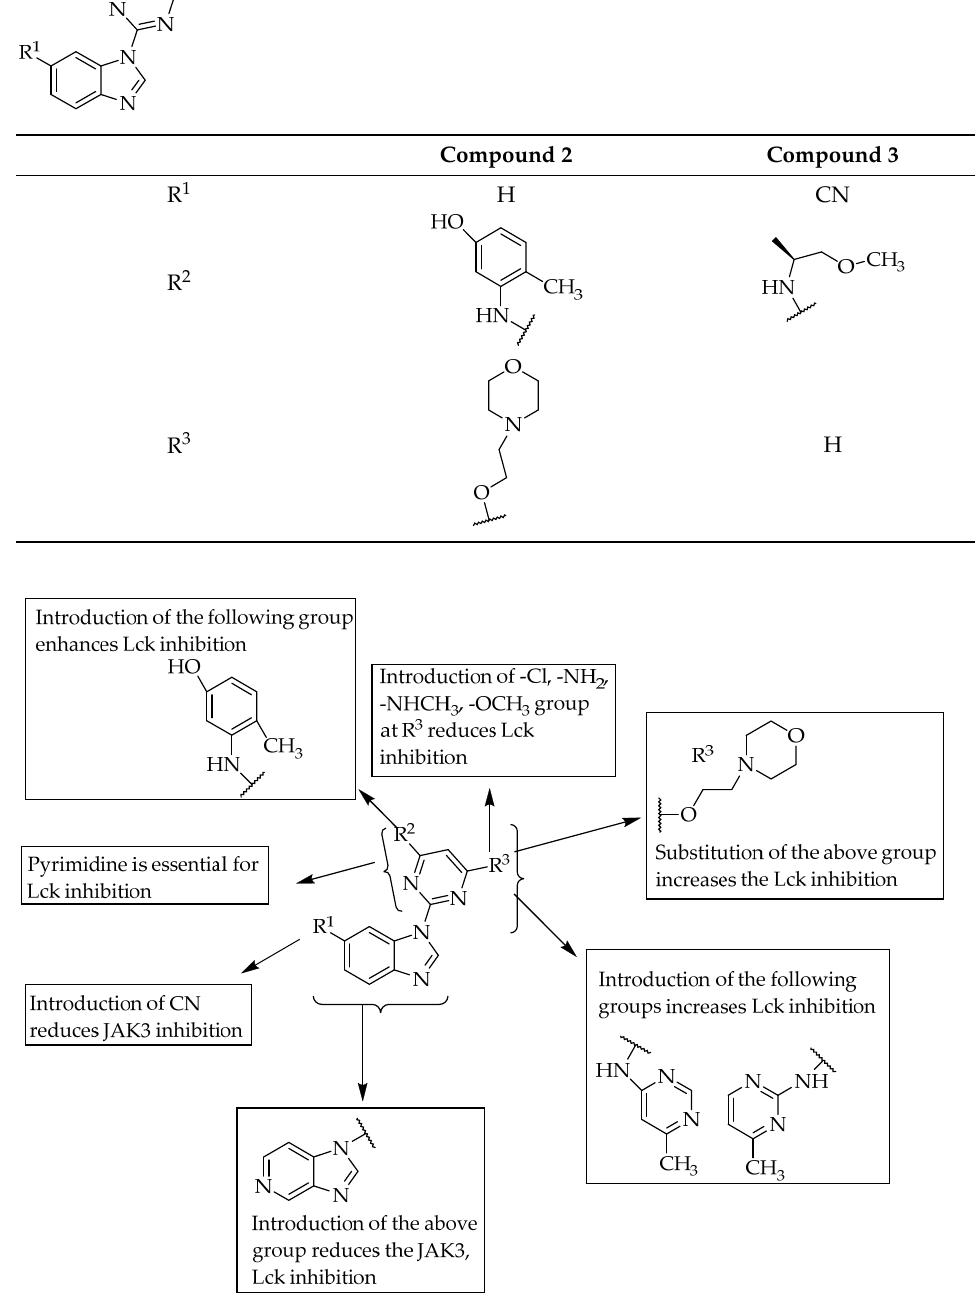
12 of 32 Figure 19. SARs of 3-methyl-1,2-disubstituted benzimidazoles. In 2006, Sabat et al. reported the anti-inflammatory effects of a few benzimidazoles